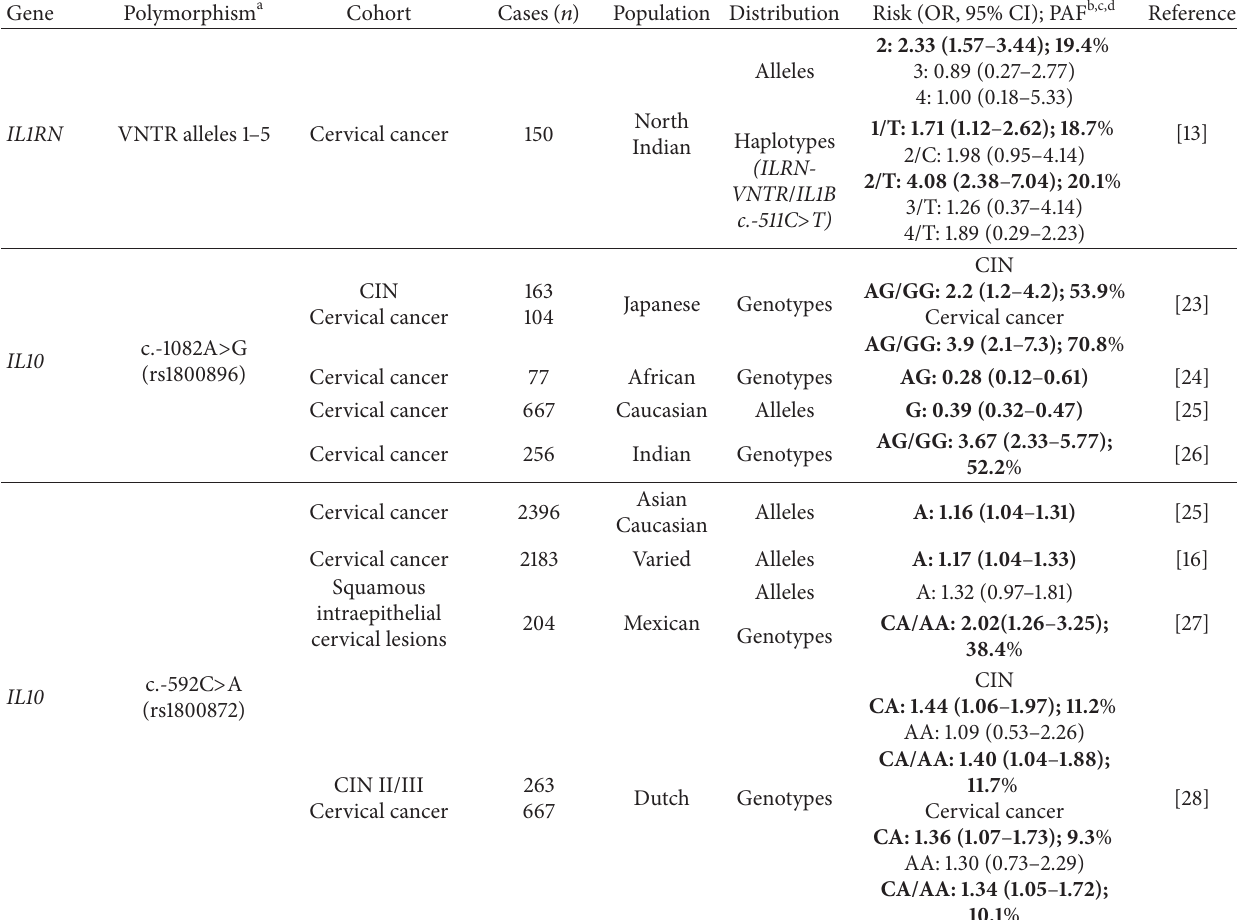
Table 2: Overview of polymorphisms in genes encoding anti-inflammatory cytokines and association with cervical neoplasia risk. Gene